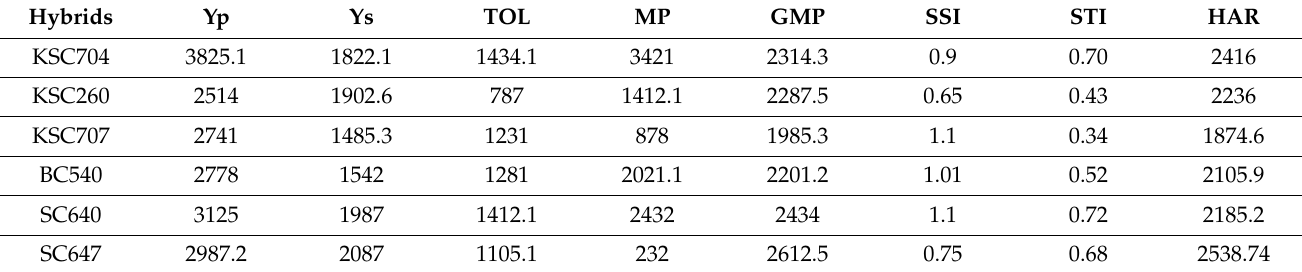
Table 2. Drought tolerance index values for maize hybrids under moderate water-stress